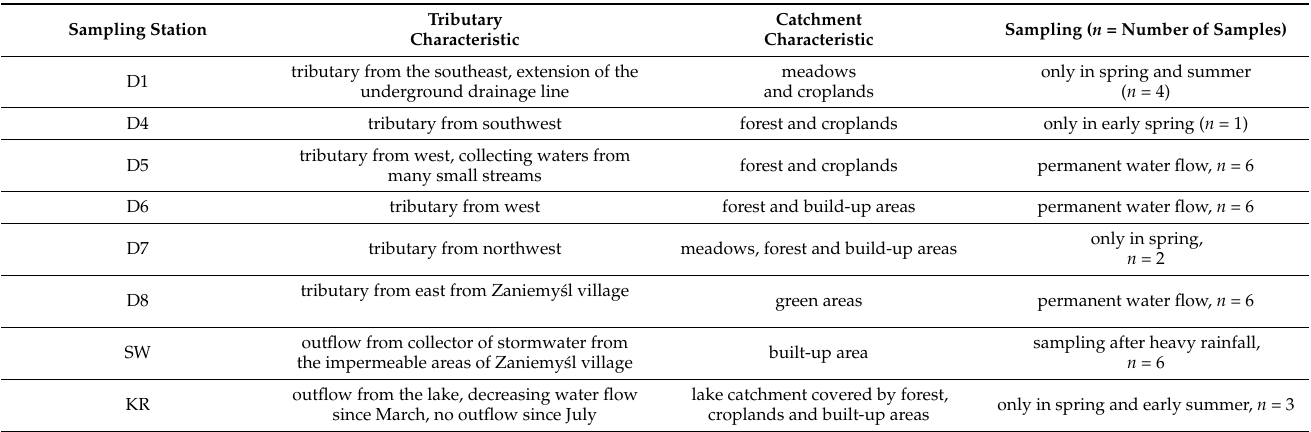
Table 1. Characteristics of watercourses and sampling